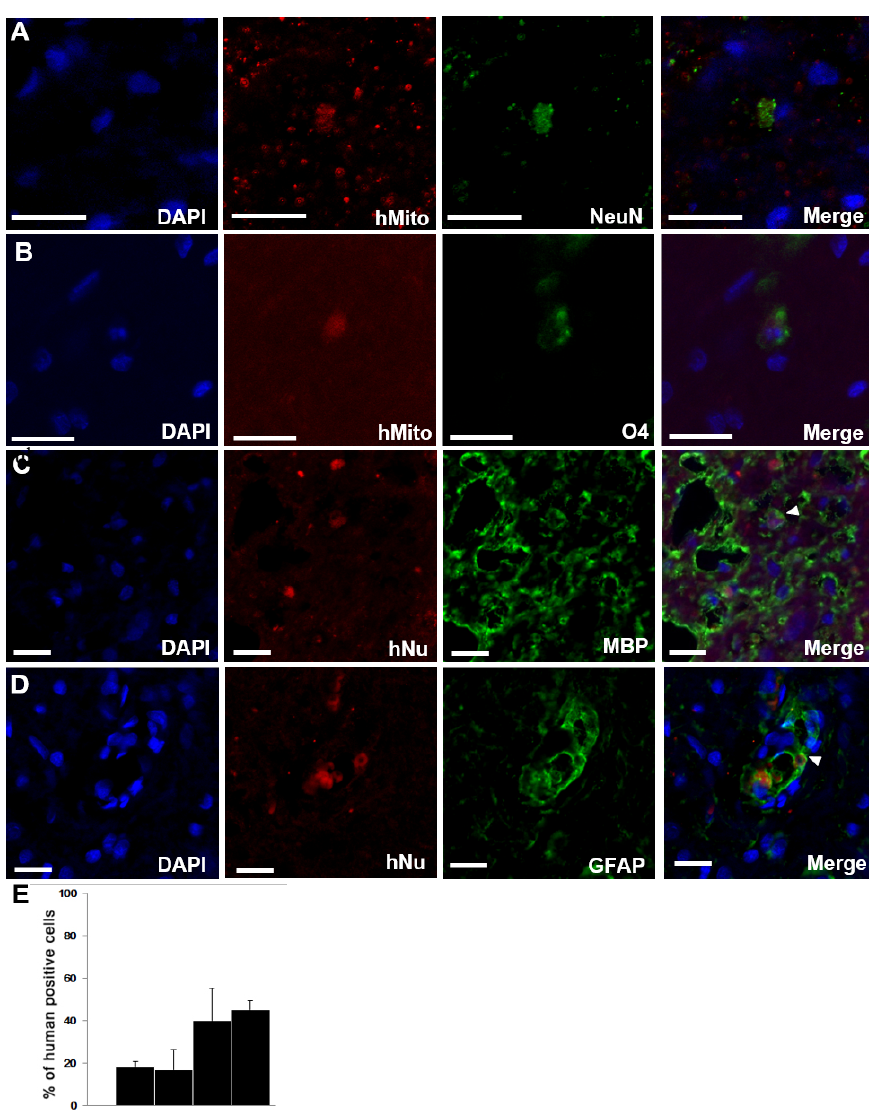
Figure 2. Differentiation of transplanted F3.BDNF cells in SCI rats. Transplanted F3.BDNF cells, co-labeled with either anti-human-specific mitochondria (hMito) or nuclei (hNu), were differentiated into ( A ) NeuN, ( B ) O4, ( C ) MBP, and ( D ) GFAP in vivo. Scale bar = 20 μm ( E ) quantitative analysis of the differentiated phenotypes into NeuN-positive neurons, O4-positive immature oligodendro- cytes, MBP-positive oligodendrocytes, and GFAP-positive astrocytes. Data are shown as means ± S.E.M ( n = 3 each).